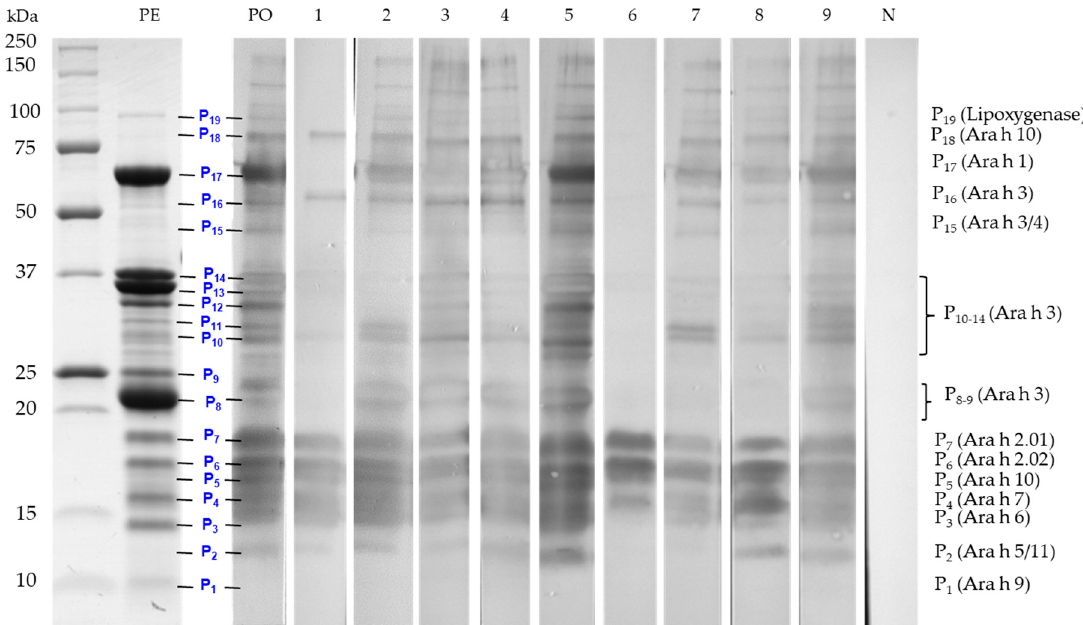
Figure 3. Electrophoretic profile of peanut (PE) and IgE immunoblots of peanut protein extracts with a serum pool (PO) of 9 peanut allergic patients and with each individual patient’s serum (1 – 9). A mite negative serum (N) was used as a control.